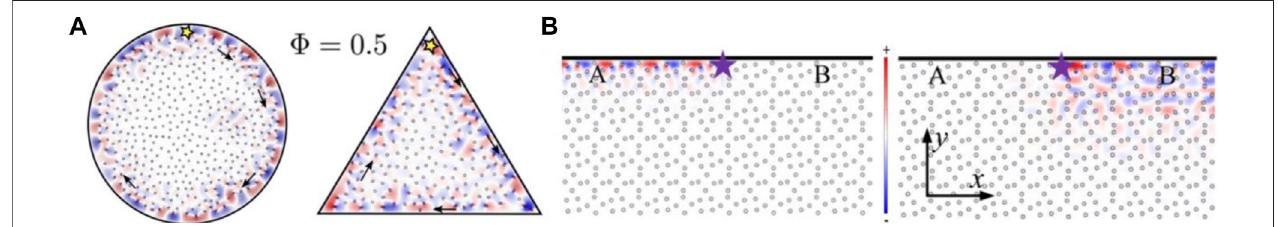
FIGURE 2 | (A) Robust edge propagation in amorphous lattices with circular and triangular shapes (Mansha and Chong, 2017). (B) One-way waveguide propagation fi eld pro fi les at the edge of the supercell gyromagnetic PhC con fi guration with star source in different frequency (Yang et al.,